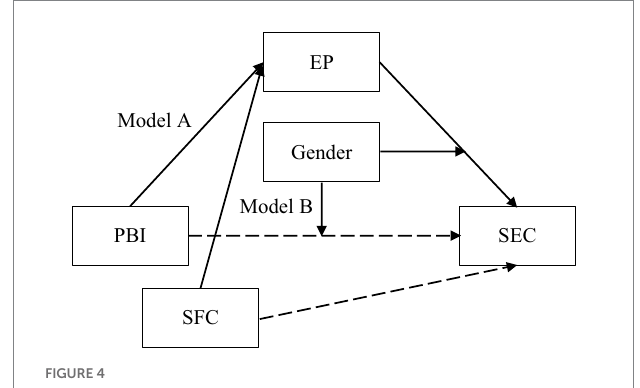
FIGURE 4 The moderated mediation model. PBI, parental beliefs and interests; SFC, structural family characteristics; EP, educational process; SEC, children’s social–emotional competence. Model A: Gender moderates PBI, EP, and SEC. Model B: Gender moderates SFC, EP, and